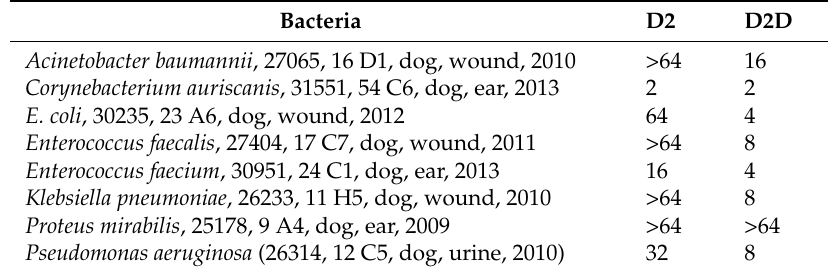
Table 4. Spectrum of antimicrobial activity of D2 and D2D against a broad range of canine isolates, including Gram-positive and Gram-negative